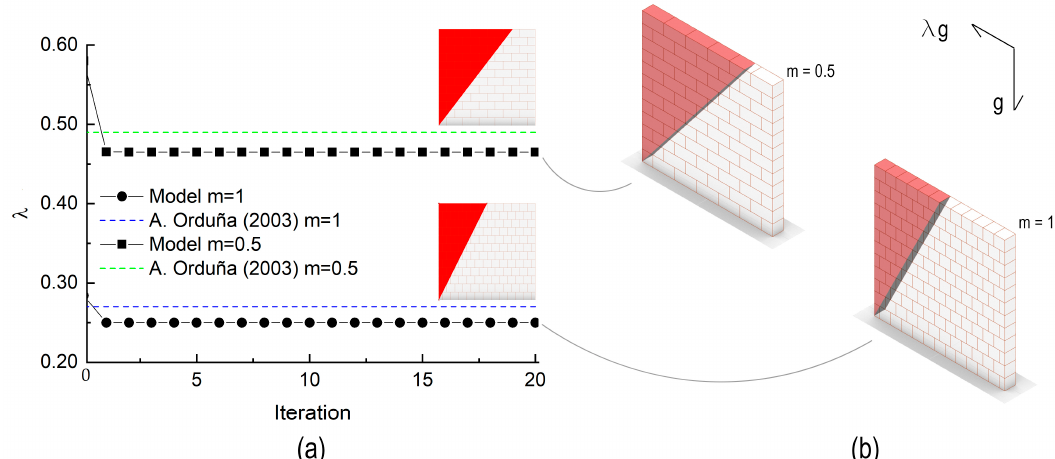
Figure 5. ( a ) Load multiplier vs. Iterations for m = 1 and m = 0.5 and comparison with the reference value arising from the micro-block model [38]. ( b ) Geometry representation of the failure mechanism at the last iteration.